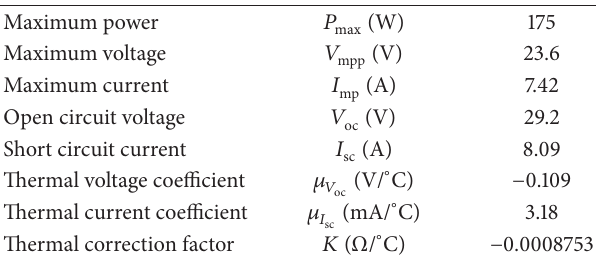
Table 1: Thermoelectrical features of the Kyocera KC175GHT-2 at STC.